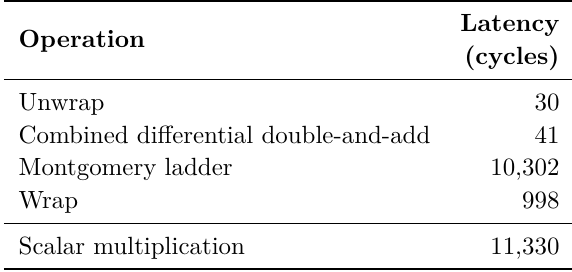
Table 4: Latency of high-level functions.